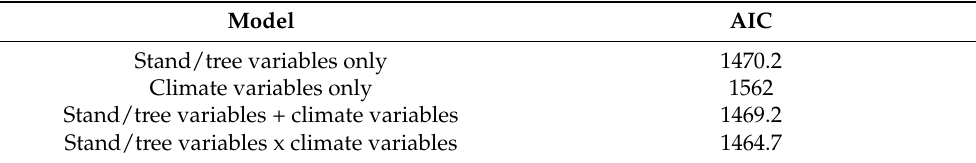
Figure 5. Regression lines derived from the final interaction model in Objective 3. The change in log odds of insect-caused mortality (relative to the mean value of elevation) is shown on the y -axis, controlled for the other components in the model. Data are split by average annual precipitation. In relatively dry stands, the risk of mortality rises quickly with elevation, but in relatively moist stands, the elevation-associated increase in mortality risk is less pronounced (precip × elevation, p = 0.0013). Table 2. Akaike information criteria (AIC) values for each model. The model containing only stand/tree variables (diameter, crown ratio, ponderosa basal area, non-ponderosa basal area, el- evation) was significantly better than the model containing only climate variables (temperature and precipitation). However, the best-fit model contained stand/tree variables in interaction with climate